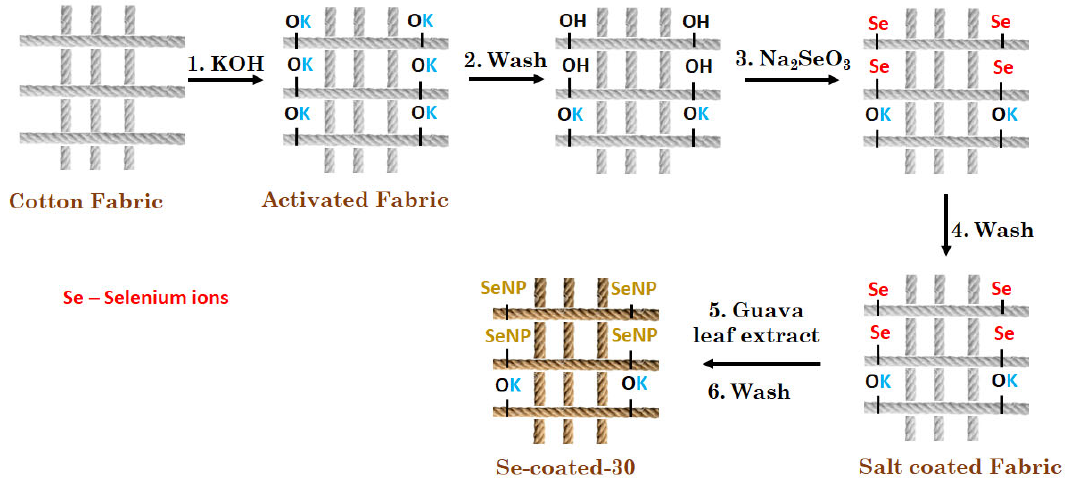
Figure 1. Illustration showing the steps involved in the in situ synthesis of Se NPs on cotton fabric. (1) Activation of fabric with KOH. (2) Washed with distilled water to expose free hydroxyl groups. (3) Treatment of the fabric with sodium selenite salt. (4) Washed to remove unbound salt. (5) Reduction of selenium ions by guava leaf extract.